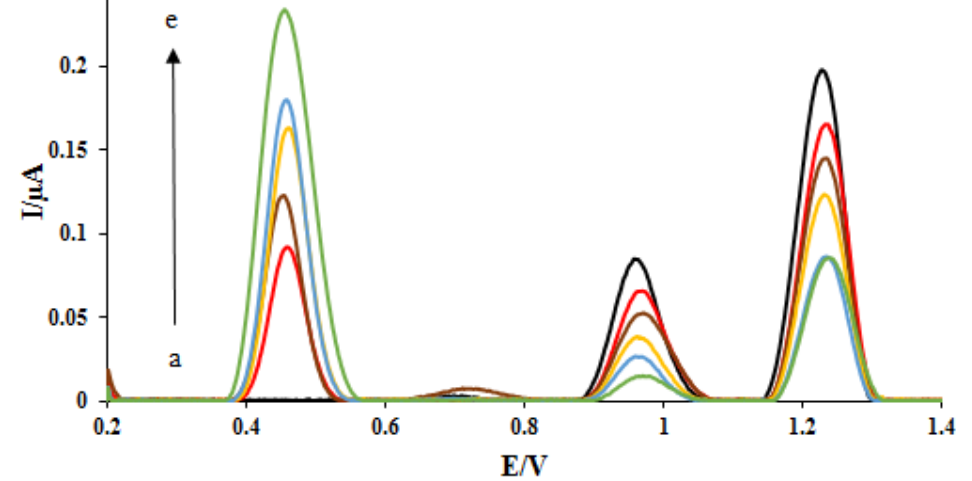
Figure 3. DPVs of DNA/rGO/GCE in acetate buffer solution (0.5 M, pH 4.8) containing 2 mg L − 1 ELT under different incubation time: 15 s (a), 30 s (b), 1 min (c), 3 min (d), and 5 min (e). The arrow shows the increasing peak current of ELT with the interaction time.